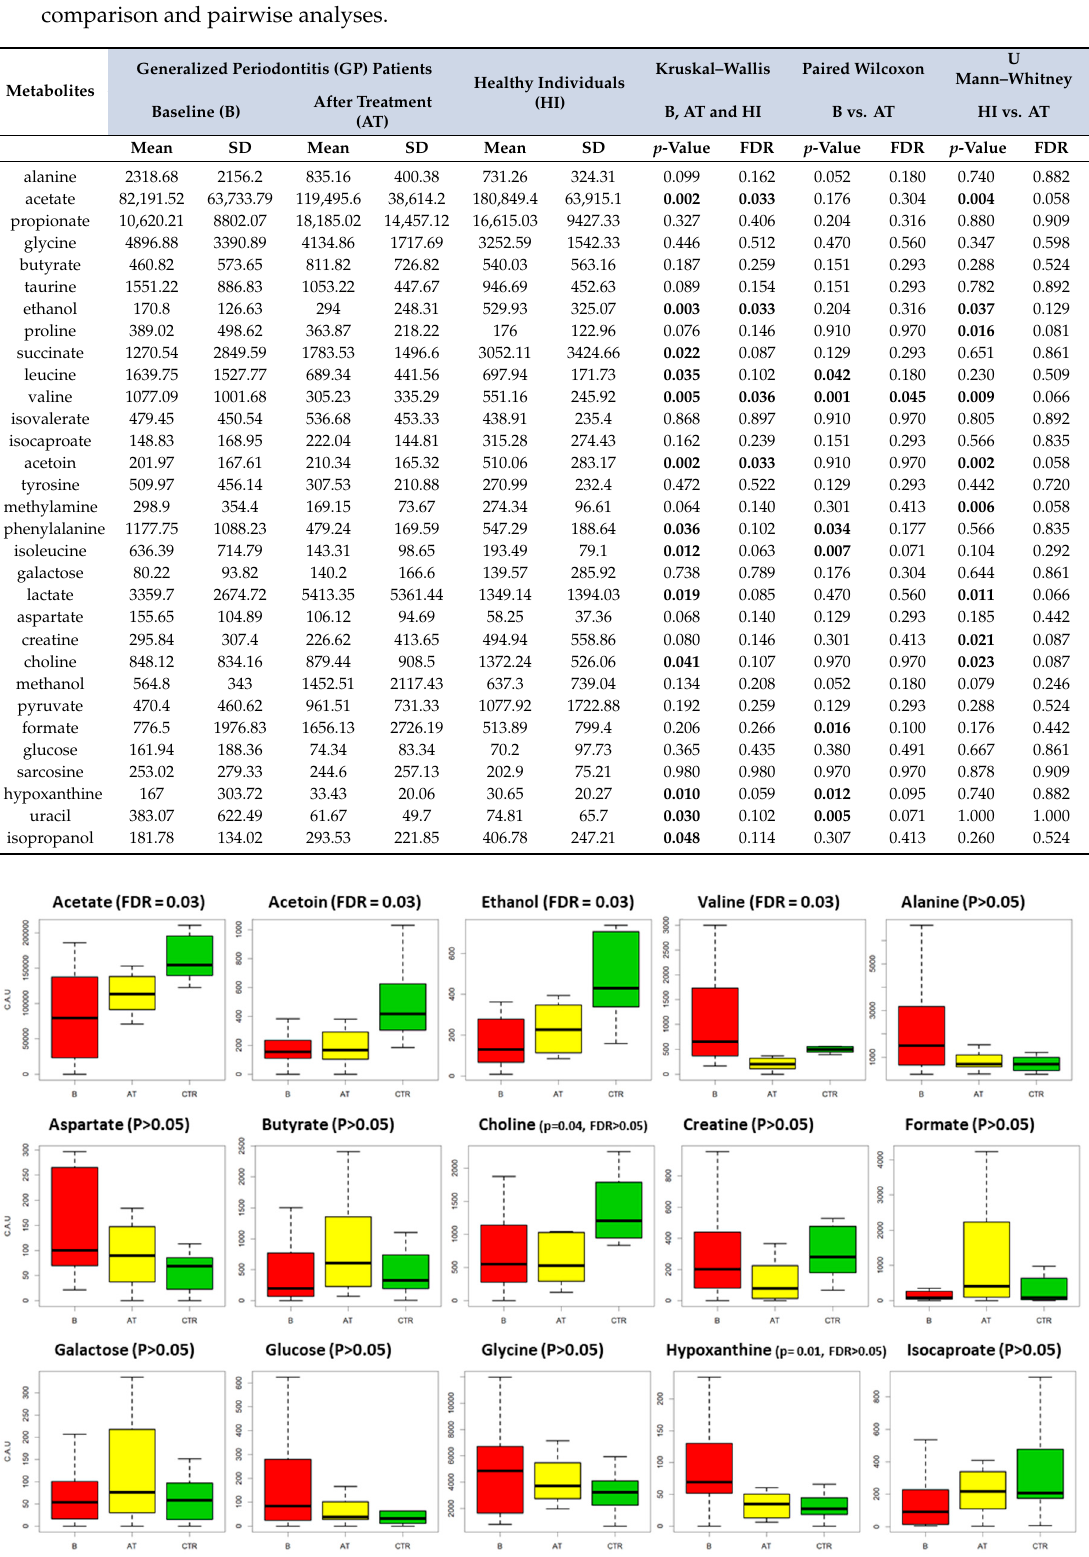
Figure 3. Boxplots representing the fluctuations of each metabolite among the three groups: GP patients at baseline (B, red box), GP patients after non-surgical therapy (AT, yellow box) and HI (healthy individuals, green box). p -value and FDR values are also reported. FDR < 0.05 is considered statistically significant.